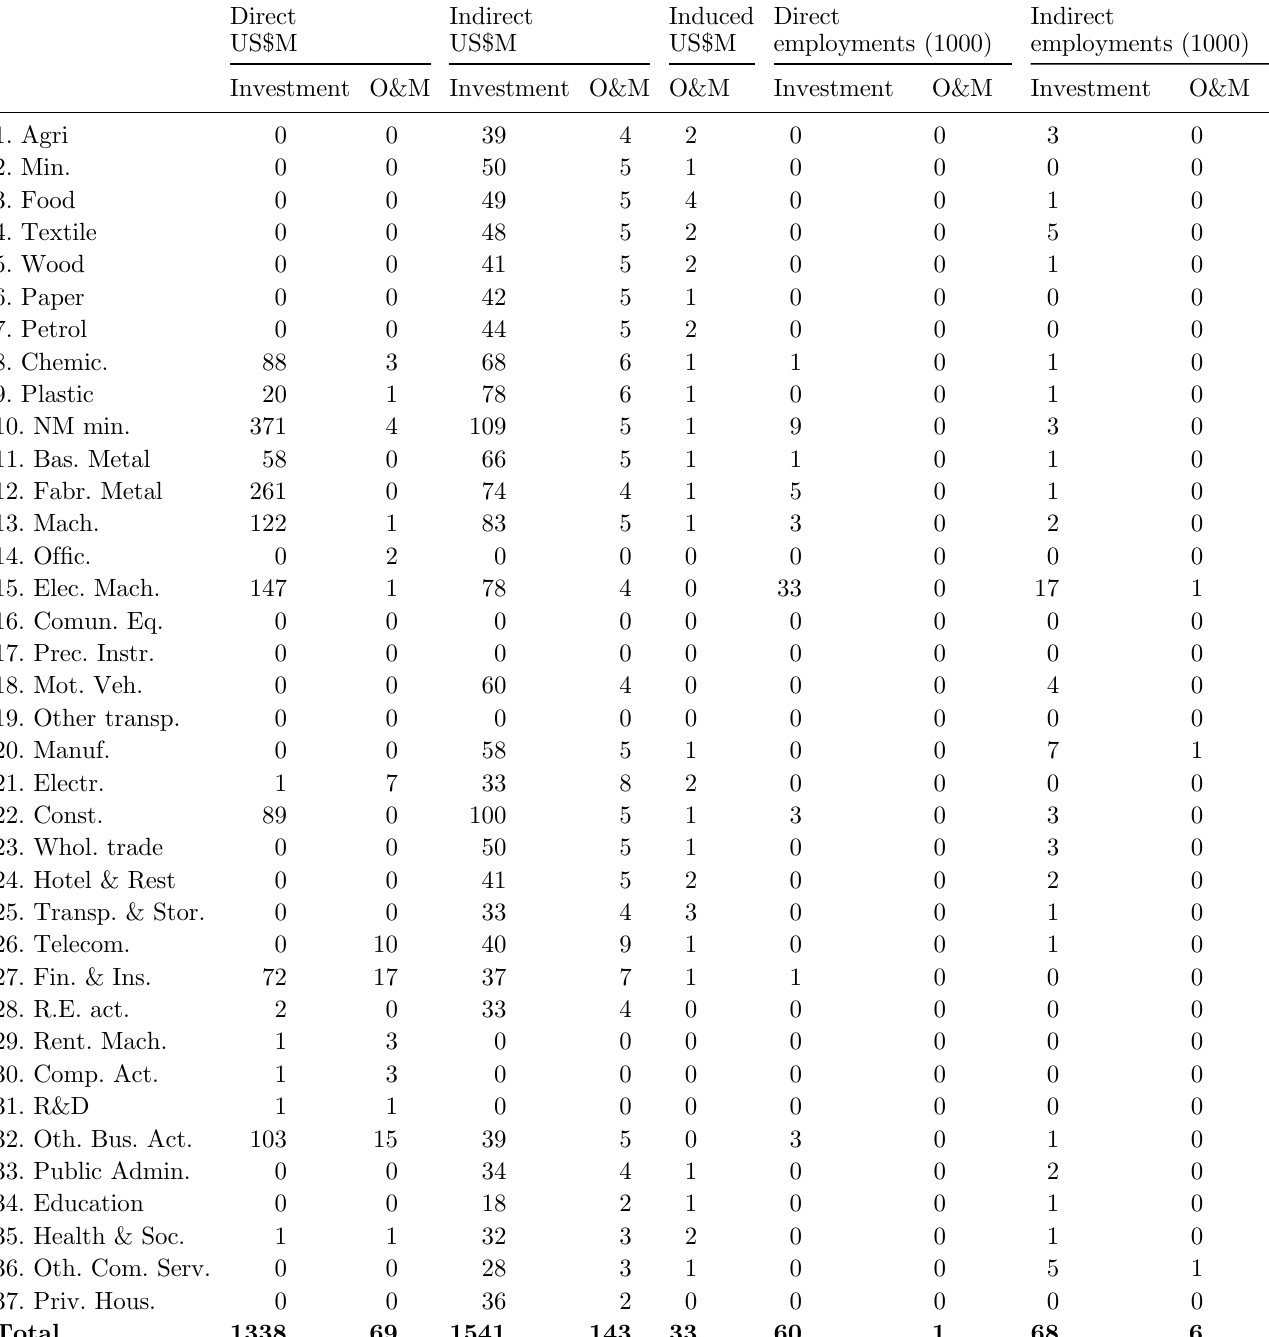
Table 1. Direct, indirect, induced economic effects and employment generation caused by the